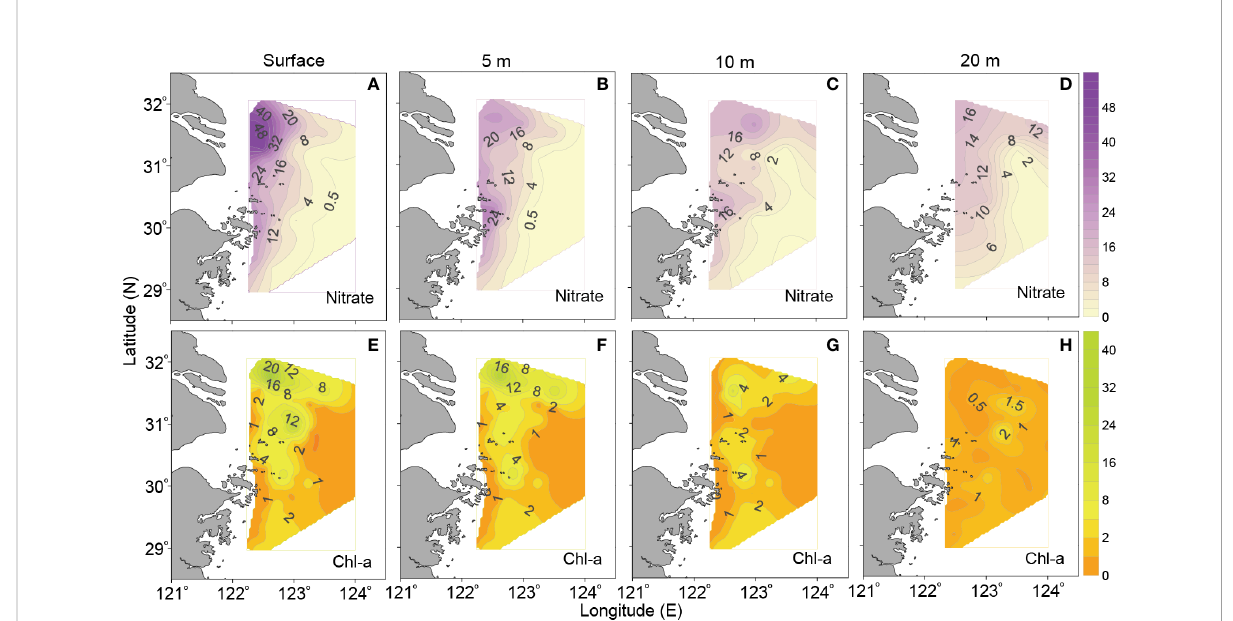
FIGURE 4 Horizontal distributions of (A – D) nitrate ( m mol dm -3 ) and (E – H) Chl-a ( m g dm -3 ) in upper layers off the CE in August 2013 (the distribution patterns of phosphate and silicate are similar to that of nitrate and hence are not